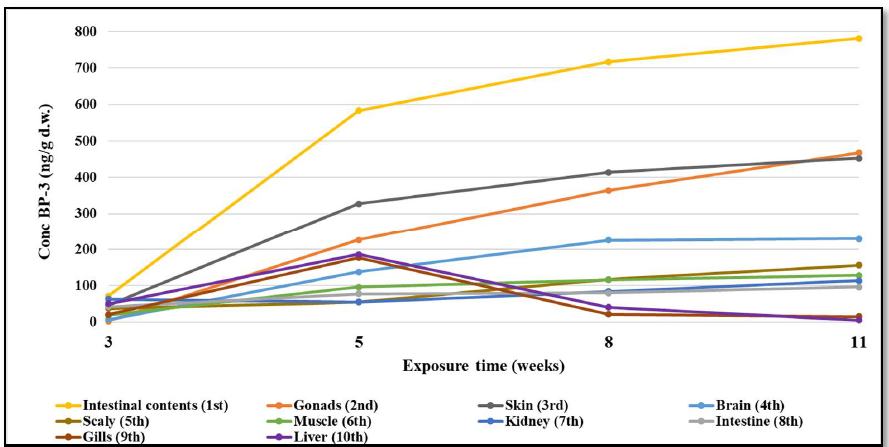
Figure 1. BP-3 concentration values detected in tissue and organs during the bioconcentration ex- periments.